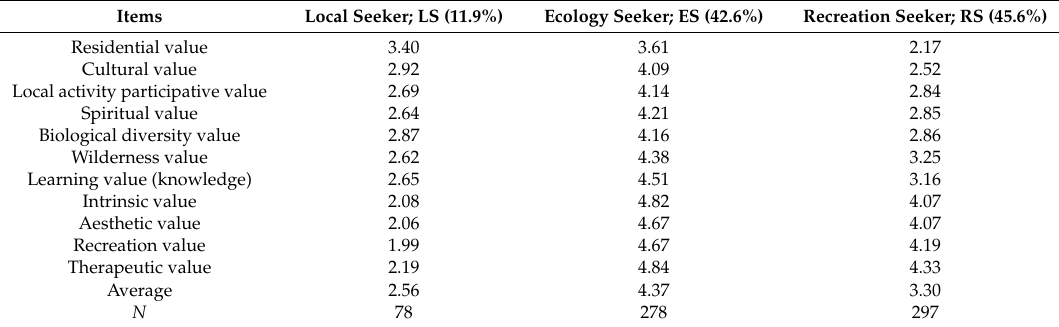
Table 6. Sample characteristic by profile.